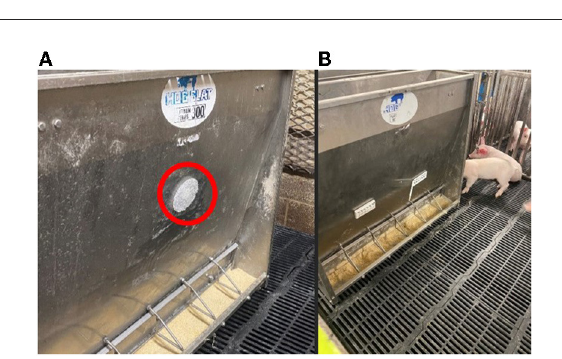
FIGURE2 Photo of the “cookie” attached to the nursery feeder just beyond the reach of the weaned pigs [ (A) , left; study 3] and plastic holder of nylon or EVA [ (B) right; study 4]. The red circle was added to point to the cookie. The plastic holder that contained either nylon or EVA cookie with infused MP is shown on the right photo. Both the cookie and nylon were impregnated with MP prior to placement on the feeders. The configuration of the left photo was also used in Study 4 for the EVA treatment.